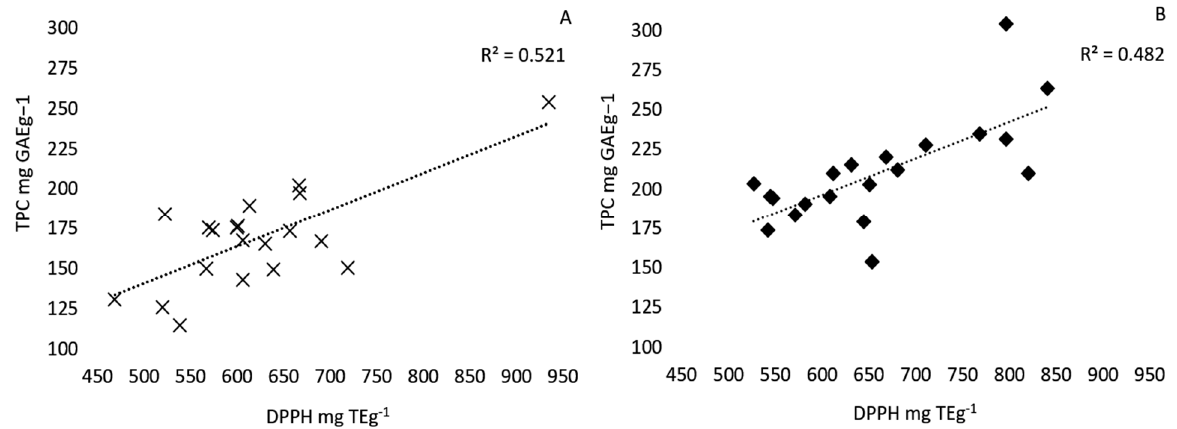
Figure 1. Correlation between the total phenolic content and antiradical activity of 20 pecan cultivar extracts. Positive linear correlation between the total phenolic content (TPC) reported as mg GAEg -1 (gallic acid equivalents per gram of dry extract) measured using the Folin–Ciocalteu assay and antiradical activity measured by the DPPH method reported in mg TEg -1 (Trolox equivalents per gram dry extract) of 20 pecan cultivars extracted by distilled water (20 g/L, 30 min, 22 °C) ( A ) or ethanol (20 g/L, 1 hr, 22 °C) ( B ) solid-liquid extraction.